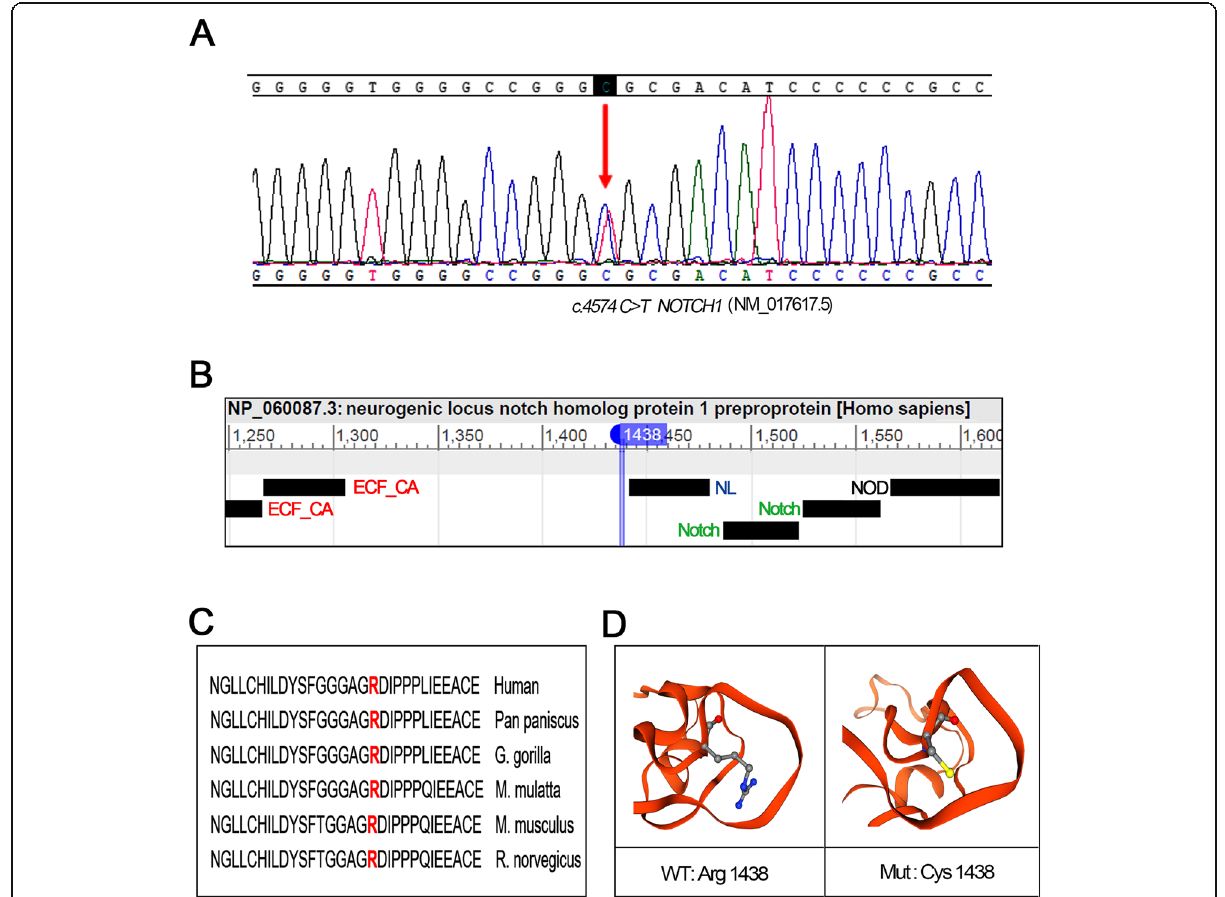
diagram of the domain regions of neurogenic locus notch homolog protein 1 preproprotein (NP_060087.3, amino acid:1250 to 1600). The mutant residue was located very close to the NL domain. EGF_CA: Calcium-binding EGF-like domain; NL: Domain found in Notch and Lin-12; Notch: Lin- 12/Notch repeat; NOD: NOTCH domain. c The protein sequence alignment showed the variant region was conserved among species. d The structure modeling of wildtype (WT) and mutant (Mut) Notch1 was built using